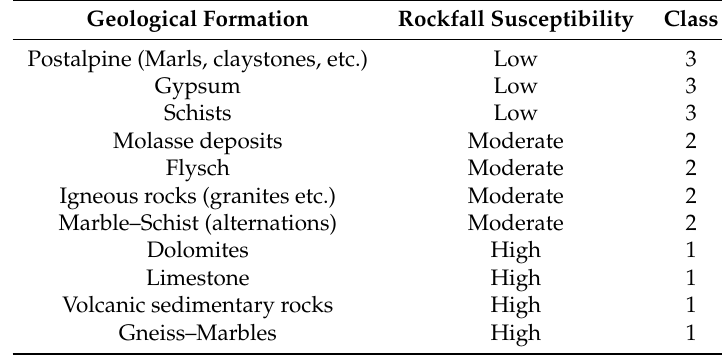
Figure 7. Main geological units encountered in Greece. Table 3. Rating of lithology.